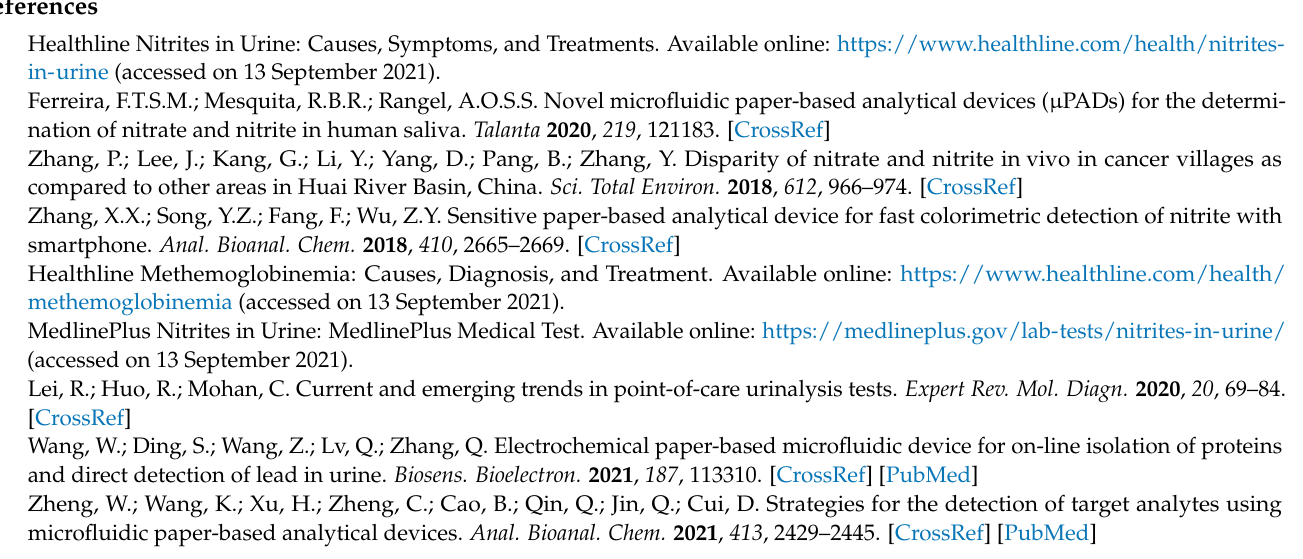
Papers used, Figure S1: Plot of the studied conditions in ESI Table1 and Table S2 with: (A) a 12 mM nitrate standard; and (B) a 1.2 mM nitrate standard; the error bars represent 5% relative deviation, Figure S2: Nitrite calibration curve; the error bars represent the standard